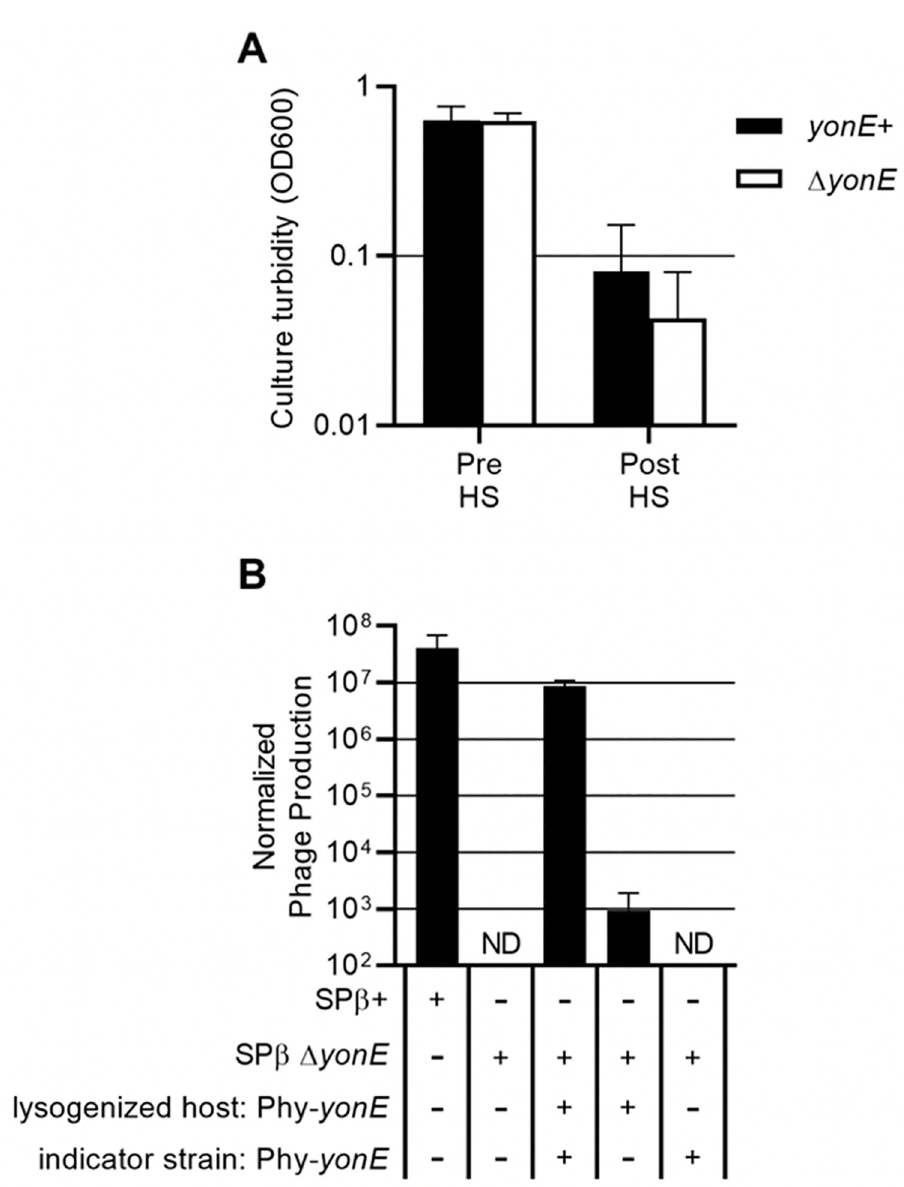
Fig 6. yonE is needed for production of infectious phage. A. Strains carrying a temperature-sensitive SPß lysogen with a wild type yonE allele (black bars, CMJ114) or Δ yonE (white bars, CMJ455) were cultured in rich medium, then heat shocked for 20 minutes (methods). The Y axis shows the average and standard deviation of the OD600 from each culture immediately before and 70 minutes ( ± 5 minutes) after the heat shock. Each experiment was repeated � 3 times. B. Phage were prepared by culturing strains with a temperature sensitive SPß lysogen with a wild type yonE allele (CMJ114), Δ yonE (CMJ455), or a Δ yonE allele with yonE complemented from the chromosome ( lacA ::{Pspank (hy)- yonE }, CMJ457) to an OD600 of approximately 0.4, and then heat shocking the cultures and collecting phage (methods). Lysates were then spread on lawns of the indicator strain CU1050 or an indicator with lacA ::{Pspank(hy)- yonE } (CMJ440) and incubated overnight to allow plaque formation. The Y-axis shows the average and standard deviation of the number of infectious phage /ml, normalized by dividing by the OD600 of the culture at the time of heat shock. ND = not detected. Each experiment was repeated � 3